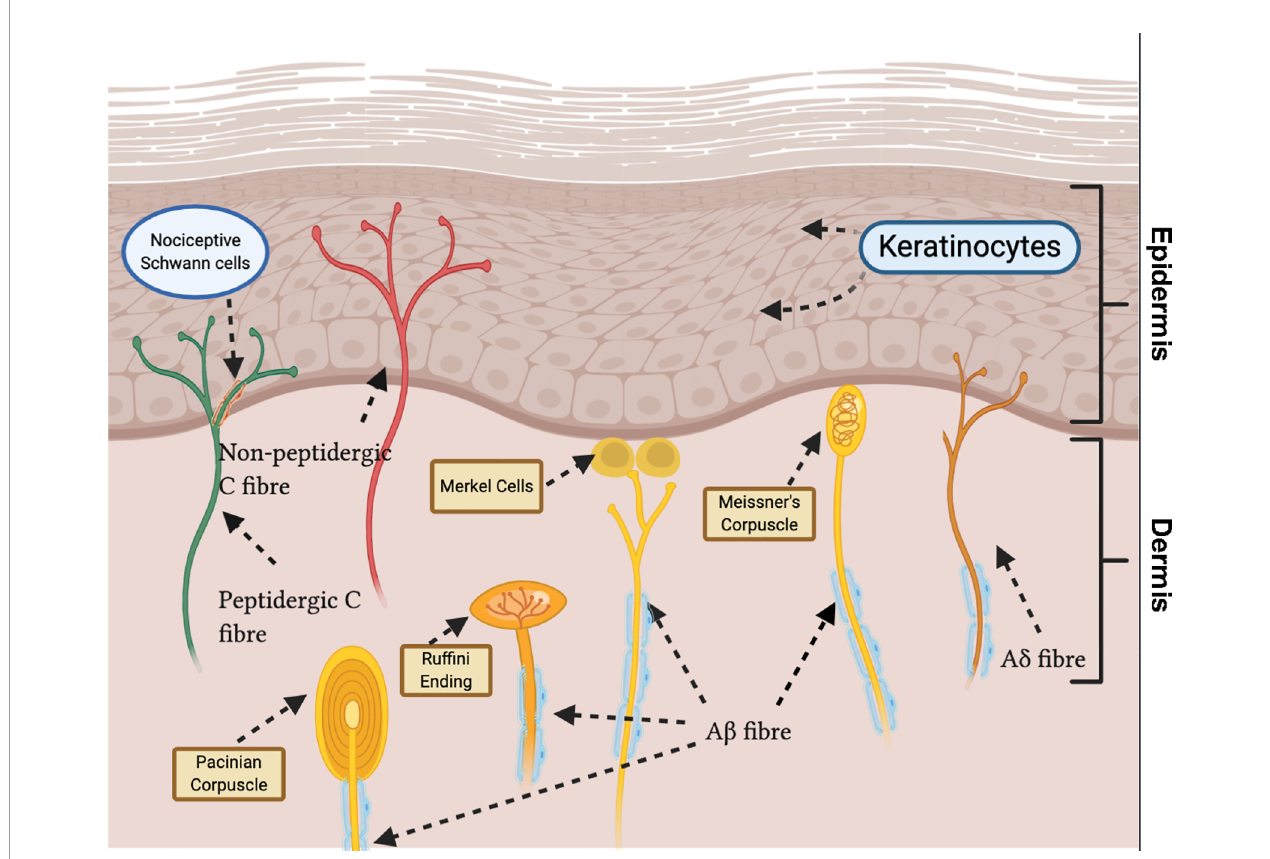
FIGURE 1 | Sensory innervation of glabrous skin displays heterogeneity in nerve ending morphology and end organ type. Unmyelinated C fi bres terminate in the deep epidermis (peptidergic) and super fi cial epidermis (non-peptidergic) as free nerve endings. A d fi bres terminate in the epidermis as free nerve endings. Recently, novel nociceptive Schwann cells ensheathing free nerve endings have been discovered. Myelinated A b fi bres terminate as: Pacinian corpuscles, in the deep dermis; Merkel cells, at the epidermal basement; Meissner ’ s corpuscles, in the dermal papillae; Ruf fi ni endings, in the